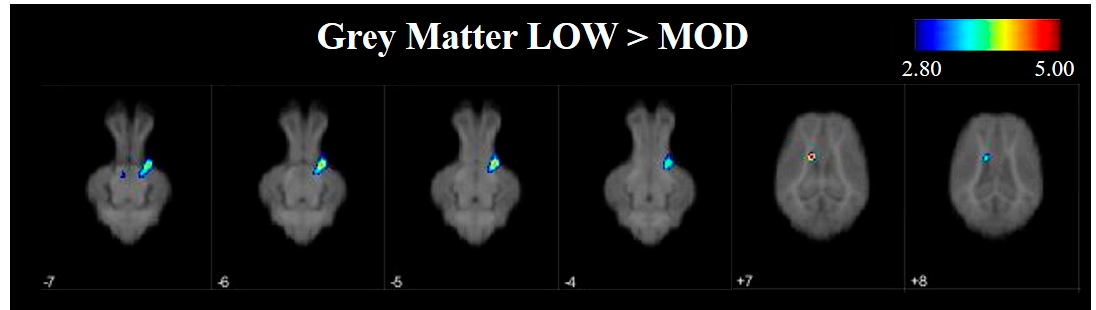
Figure 4. Voxel-based morphometry (VBM) heat maps illustrating grey matter tissue concentration differences between LOW and MOD dietary sialyllactose (SL) pigs. The colored bar indicates pseudo-t statistics, used to determine the p -uncorrected statistics provided in Table 1. Shown above are areas in which LOW dietary SL pigs exhibited greater ( p < 0.01) concentrations of grey matter when compared with MOD dietary SL pigs. For a more comprehensive set of VBM images the reader is referred to Supplemental Figure 2.